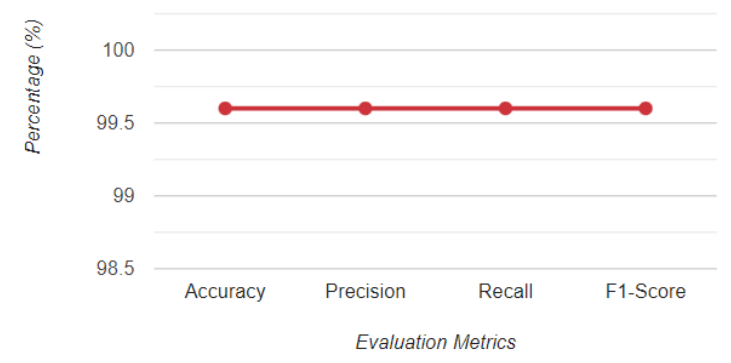
Figure 9. The Random Forest Classifier Model Performance. Table 8. Ensemble Model